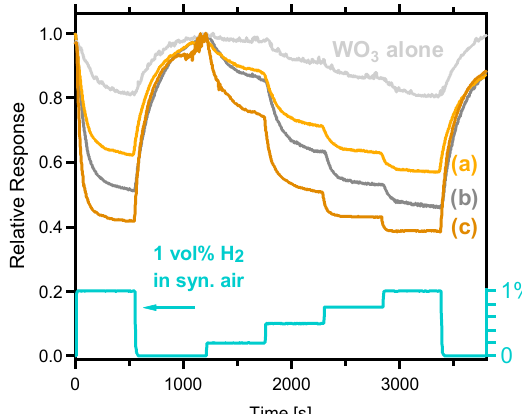
Figure 2. Relative response (i.e., relative resistance change) towards time-varied hydrogen concentration in synthetic air. The optimum temperature was picked for individual structures. See caption of Figure 1 for traces